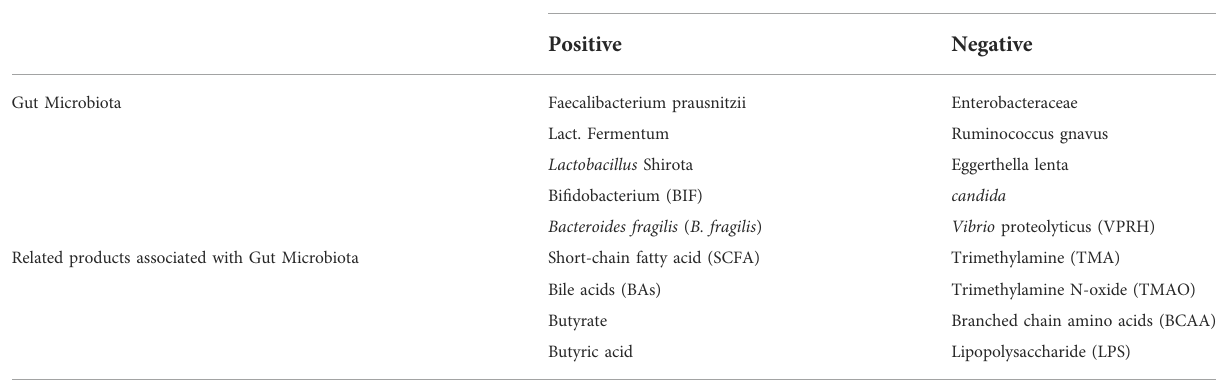
TABLE 1 The in fl uence of different gut microbiota and related products associated with diabetic